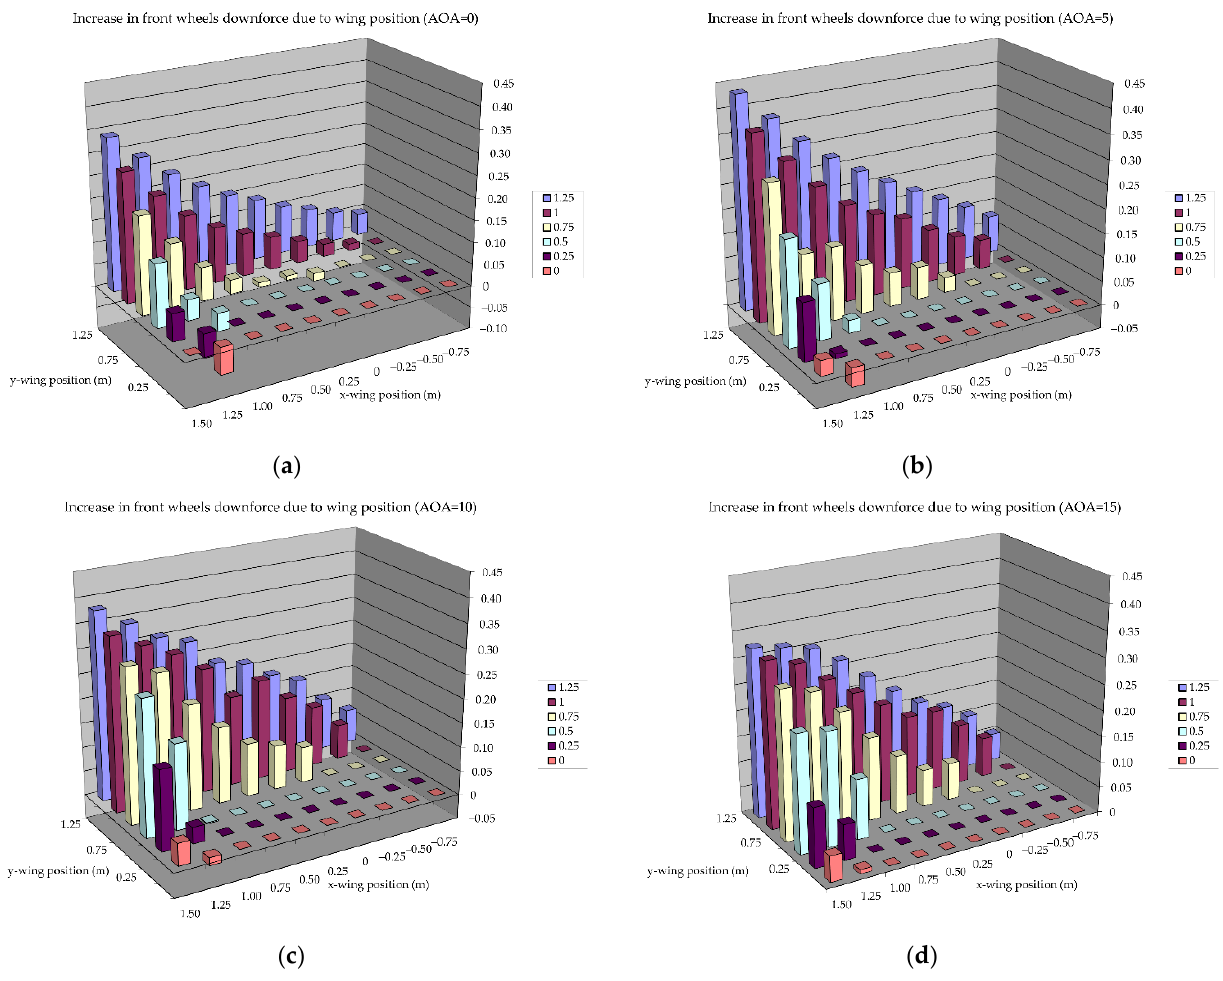
Figure 21. Increases in front wheel aerodynamic downforce coefficient as a function of the angle of attack and wing position in relation to the car body: ( a ) AOA 0 degrees; ( b ) AOA 5 degrees; ( c ) AOA 10 degrees; ( d ) AOA 15 degrees.